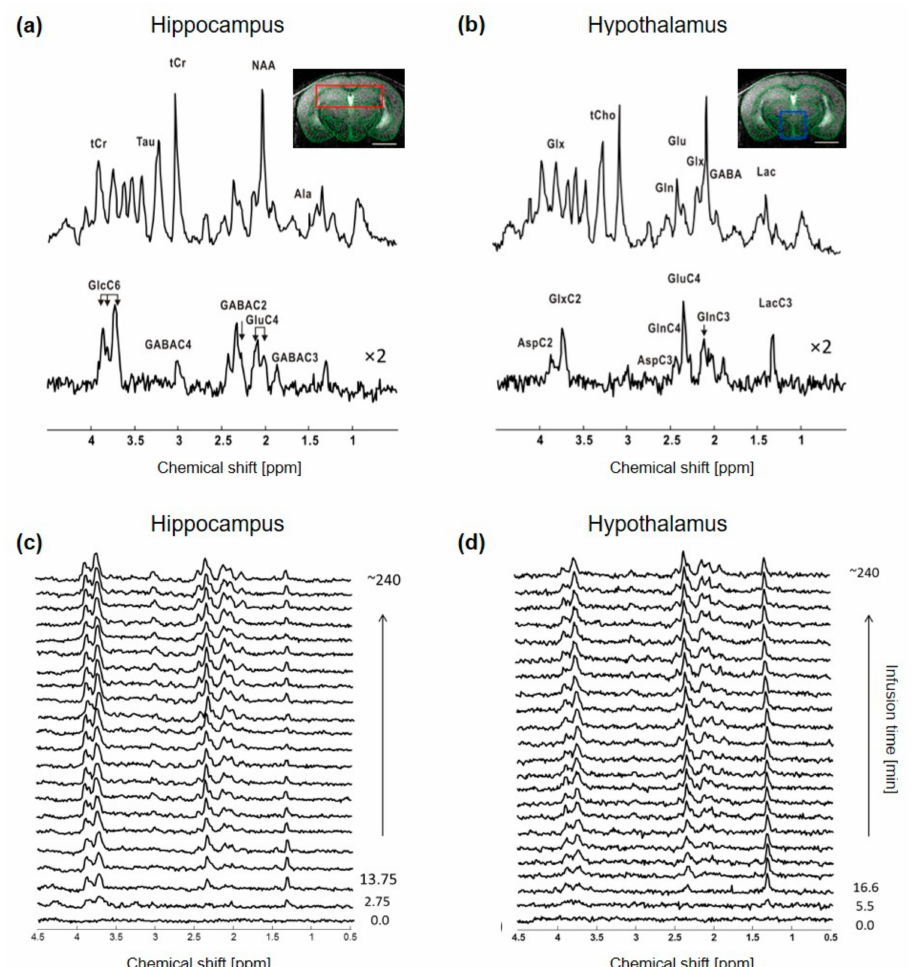
Figure 1. In vivo 1 H-[ 13 C]-MRS acquisition in mouse hippocampus and hypothalamus. Typical 1 H-[ 13 C]-MRS spectra of ( a ) hippocampus and ( b ) hypothalamus of a mouse. The non-edited (top) and edited (bottom) spectra are presented with a Lorentzian apodization of 1 Hz for hippocampus and 2 Hz for hypothalamus and the volume of interest (VOI) is shown in the anatomical image for hippocampus (red, ( a ) panel) and hypothalamus (blue, ( b ) panel). Peak labeling was distributed between the two spectra to avoid over-crowding. Abbreviations: Ala, alanine; Asp, aspartate; Gln, glutamine; Glu, glutamate; Glx, glutamine + glutamate; Tau, taurine; tCr, total creatine; GABA, γ -aminobutyric acid; Lac, lactate; Glc, glucose. Proton resonances bound to specific carbon are indicated by C and followed by the position number, e.g., C2, C3 and C4 etc. Timeline of typical edited spectra of ( c ) hippocampus and ( d ) hypothalamus showing glucose 13 C labeling incorporation to its downstream brain metabolites throughout the infusion time (minutes). In ( c ), every other edited 1 H-[ 13 C]-MRS spectra were displayed. All spectra are shown with 5 Hz Lorentzian